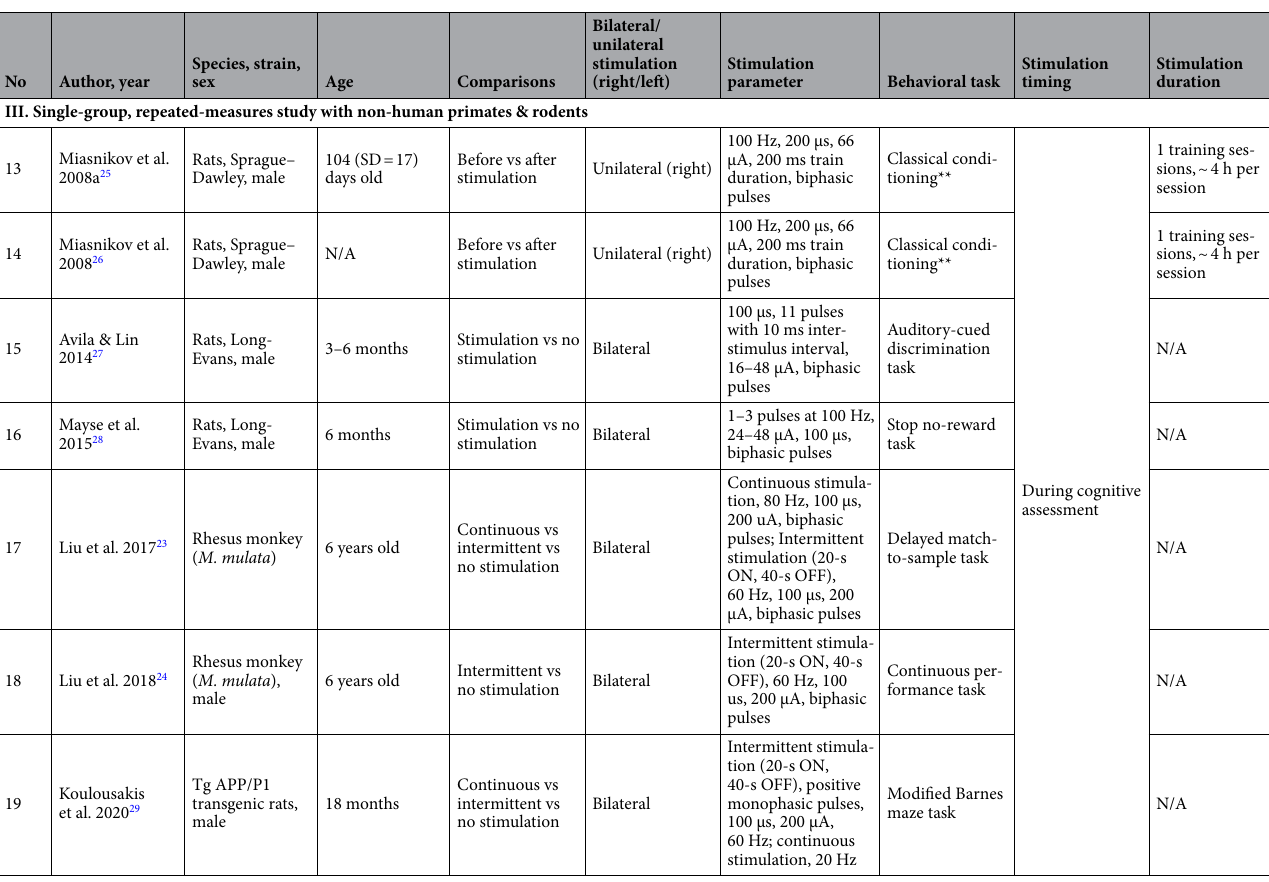
Table 1. Characteristics of animal studies with information on the effect of NBM DBS on behavioral cognitive outcomes. N/A data is not available. *left or right NBM, the number within the group was made. **sound of 8-kHz tone as the conditioned stimulus, NBM stimulation as the unconditioned stimulus, and respiratory change index as the conditioned response